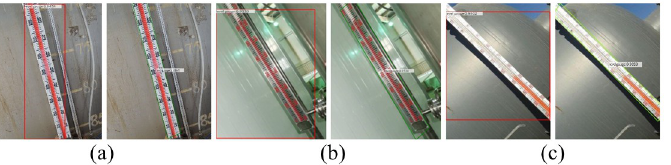
Fig 12. Comparison diagram of level gauge detection. (a) small angle tilt detection (b) moderate angle tilt detection (c) large angle tilt detection. In Fig (a), (b) and (c), the left-hand picture is the detection result of the Faster R-CNN algorithm, and the right-hand picture is the detection result of the ROMS R-CNN algorithm. In Fig(a), the tilt angle of the level gauge is small. The tilt angle of the level gauge in Fig(b) and (c) gradually increases. The prediction box in the left picture contains a large number of irrelevant background regions, and the bounding box regression effect is not ideal. The skew prediction box on the right has removed the irrelevant background area.